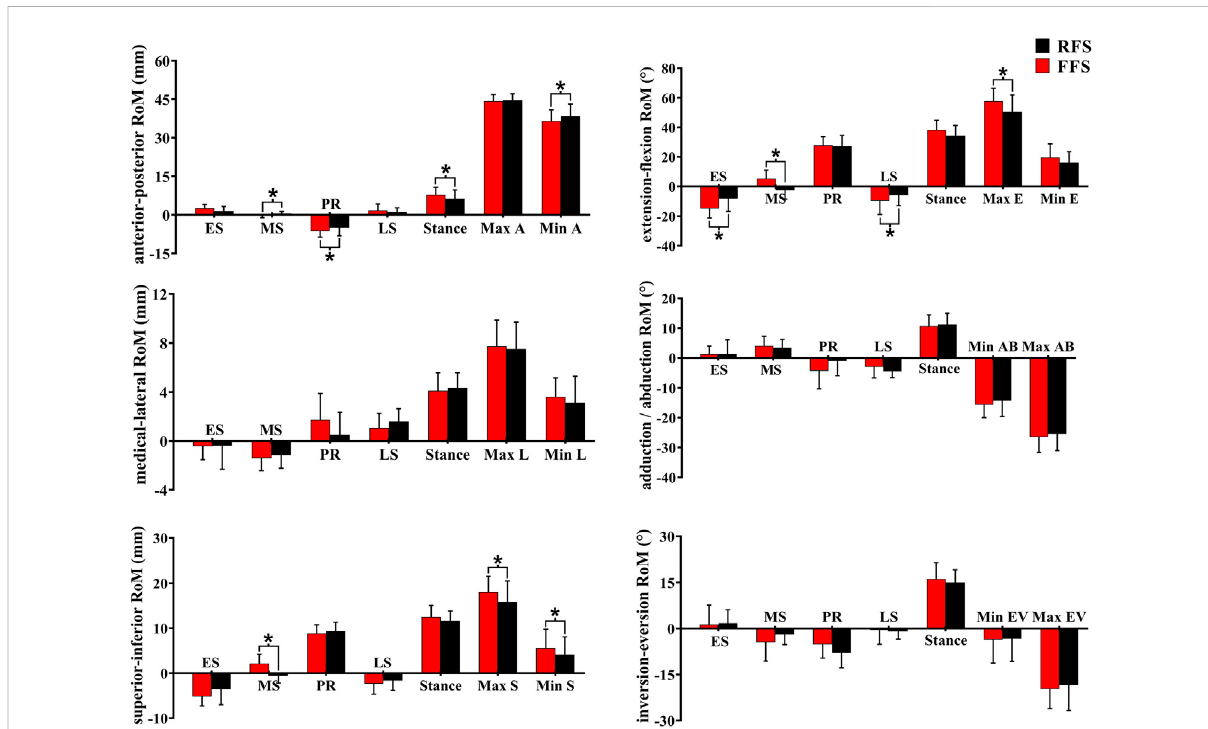
FIGURE 9 Effects of different foot strike patterns on the ROM of the fi rst MTPJ and characteristic values during the stance phase of running. Note: RFS, rearfoot strike pattern and FFS, forefoot strike pattern; ES, early stance phase; MS, mid-stance phase; PR, propulsion phase; LS, late stance phase; stance, entire stance phase; A, anterior translation; P, posterior translation; E, extension; M, medial translation; L, lateral translation; AD, adduction; AB, abduction; S, superior translation; I, inferior translation; EV, eversion; IV, inversion. * signi fi cant difference between FFS and RFS during running, p <